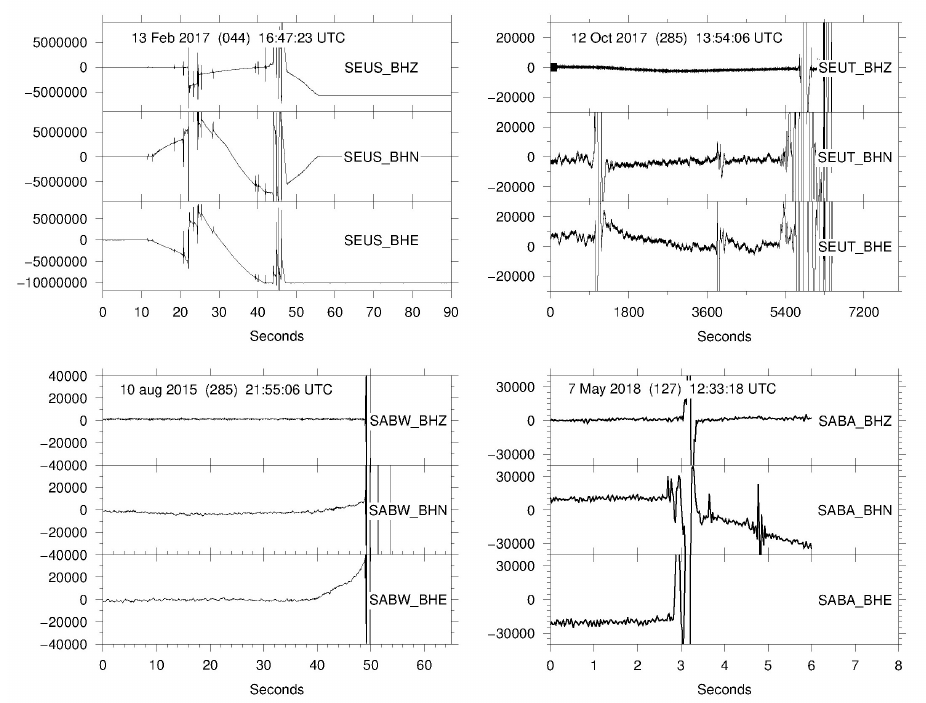
Figure 10. Four examples of the out-of-balance boom positions resulting in clipping of the recordings (different components). The amplitudes on the y -axis are given in